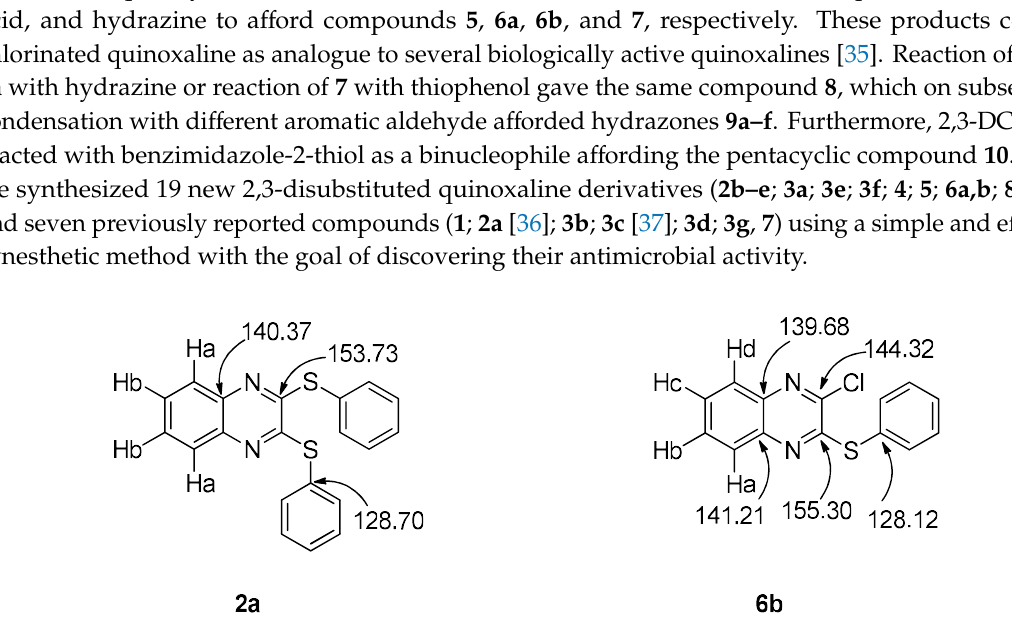
Figure 2. Quinoxaline moiety of 2a showed only two protons and two quaternary carbon in NMR. 6b showed four different types of protons and four different quaternary carbons, which correspond to its quinoxaline